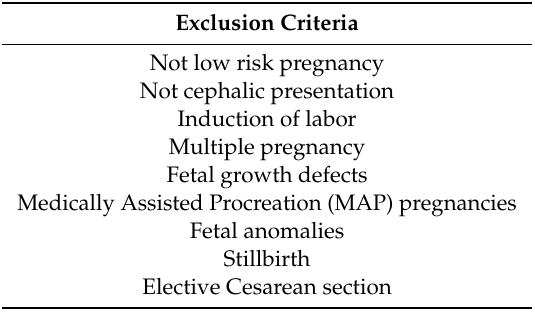
Figure 1. The two weeks belonging to the control period and the exposure period identified by daylight saving time (DST) during each year analyzed (2016–2018) are reported (grey is related with 2016, orange with 2017 and light blue with 2018). Table 1. The table shows the exclusion criteria applied on the sample.